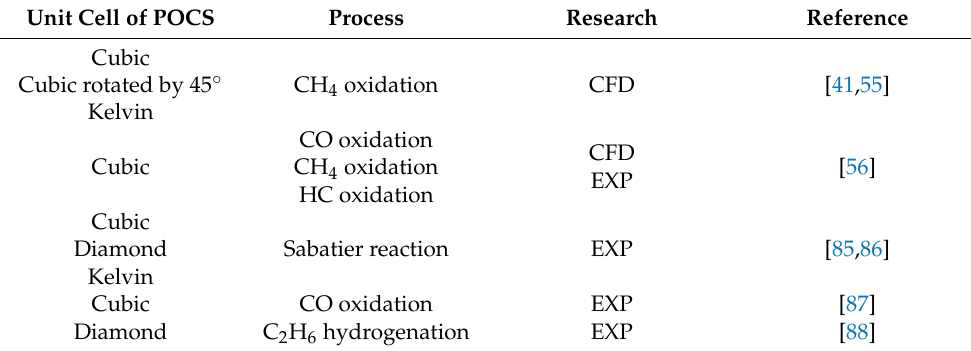
Table 1. A summary of POCS applications in